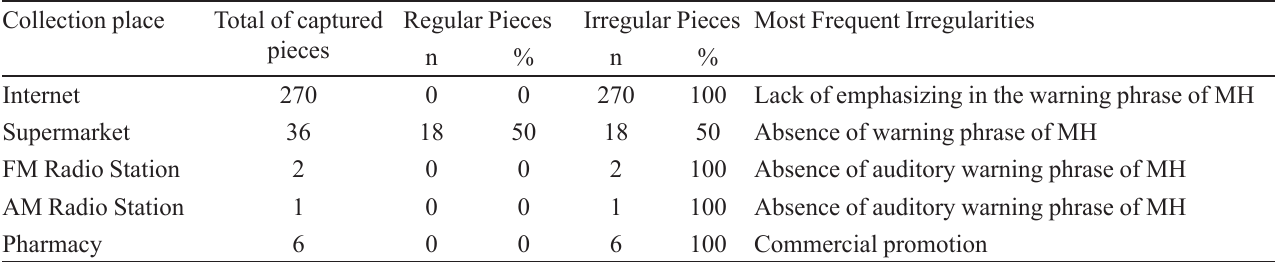
TABLE IV - Advertisement analysis of transition food and cereal based food indicated for nursling and/or children of first infancy, as well as other foods or beverages milk based or not, when commercialized or otherwise presented as appropriate for nursling and children of first infancy feeding (D), regarding legislation RDC # 222, and according the collection place Collection place